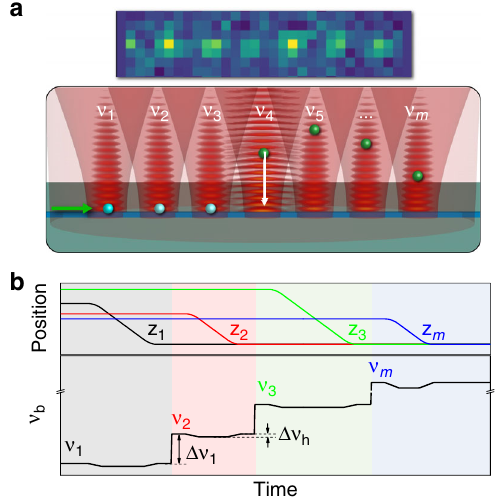
Fig. 4 Scheme for conveyor belt assisted assembly of an atom array on a nanophotonic waveguide. a Assembly begins with an array of tweezers each controlled by a frequency tone ν i and fi lled with n ≥ 1 trapped atoms as shown in the single-shot fl uorescence image (inset), followed by the conveyor transport in individual tweezers as schematically shown, with feedback control by monitoring the transmission of a resonant guided probe (green arrow) for detecting single atoms (green spheres) and pumping them into a dark state (blue spheres). b Schematic frequency- tuning pro fi le of the bottom dipole beam ( ν b ) to control the atom position z i (cid:3) ν j (cid:2) f in individual tweezers. When the frequency shift j ν (axial trap i b a frequency), tweezer i forms a time-averaged stationary lattice as shown in Fig. 1a. The time-dependent conveyor transport can be initiated only when j ν (cid:3) ν j (cid:4) f , as illustrated in a where ν b ≈ ν i b a the AOD ( i = 1,2,..., m ). For the tone spacing much greater than the axial trap frequency f a < 900 kHz (Methods), one counter- propagating dipole beam that spatially overlaps with all tweezers can transport trapped atoms in individual tweezer lattices, one at a time. Figure 4b schematically illustrates a pro fi le of the frequency ν b of the (counter propagating) bottom dipole beam for such an operation. Within time segment i marked by a color shaded area, the conveyor transport initiates when ν b ≈ ν i and can be terminated by feedback from a resonant probe, followed by a ) to the next frequency tone rapid change (within a time (cid:4) 1 = f a ν = ν + 1)-th tweezer lattice into a conveyor b i + 1 to convert the ( i belt and revert the i -th tweezer back to the original stationary